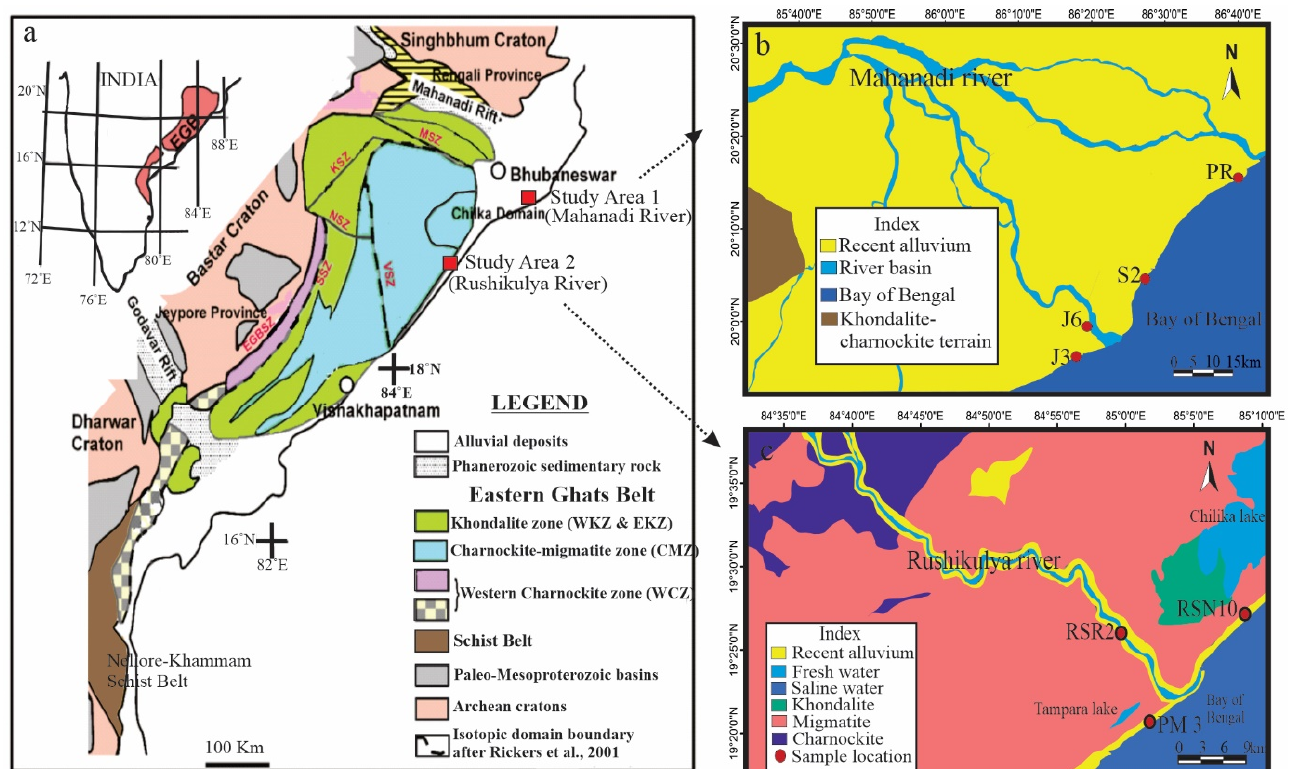
Figure 1. ( a ) Geological map of both study areas 1 and 2 (modified after [16]). ( b ) Location of sample collections from the Mahanadi river catchment area. ( c ) Location of sample collections from the Rushikulya river catchment area and adjacent beach.